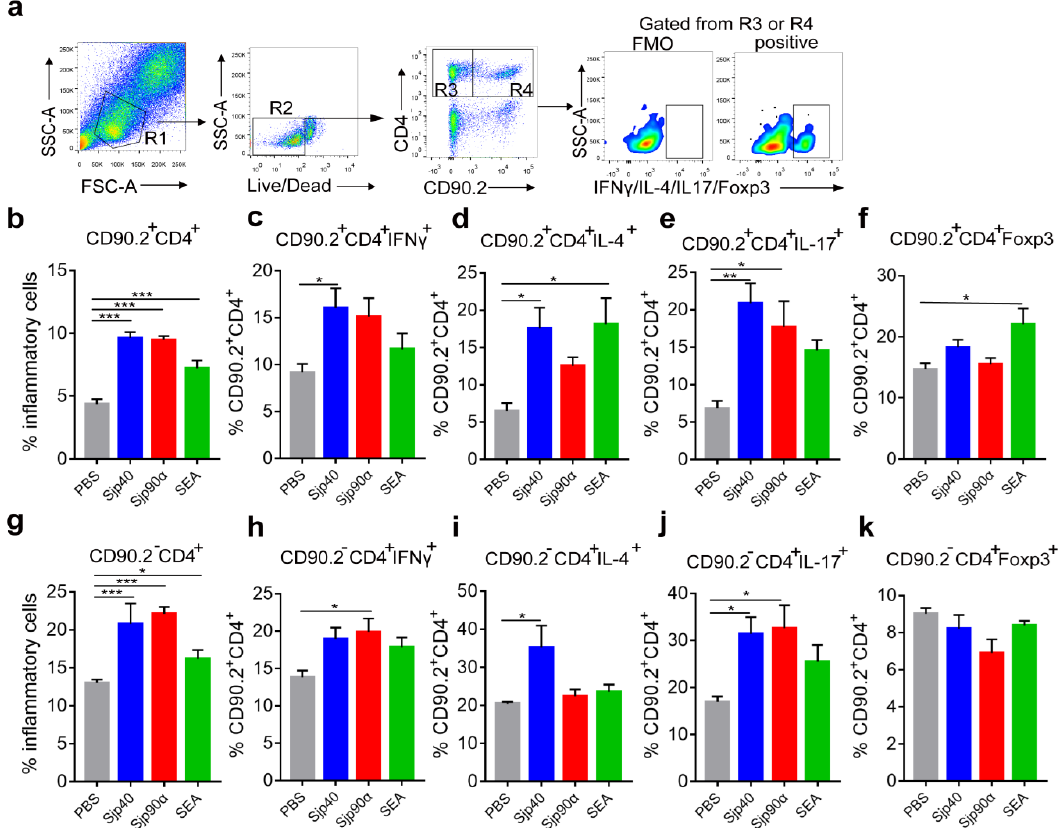
Figure 6. Mouse liver CD4 + T cells response induced by rSjp40 and rSjp90α. Hepatic immune cells (2 × 10 6 ) from S. japonicum -infected mice were treated with rSjp40 (20 µ g / mL), rSjp90α (20 μg/mL) and